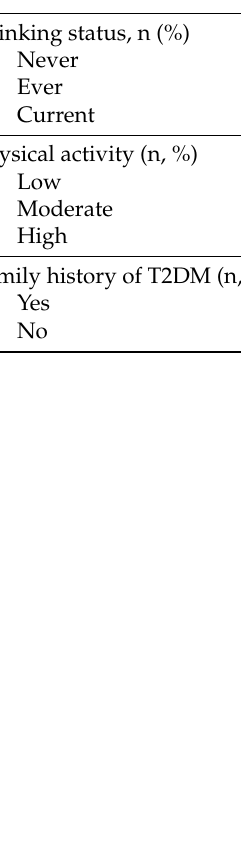
Table 2. Associations of SOCS3 methylation level with abdominal